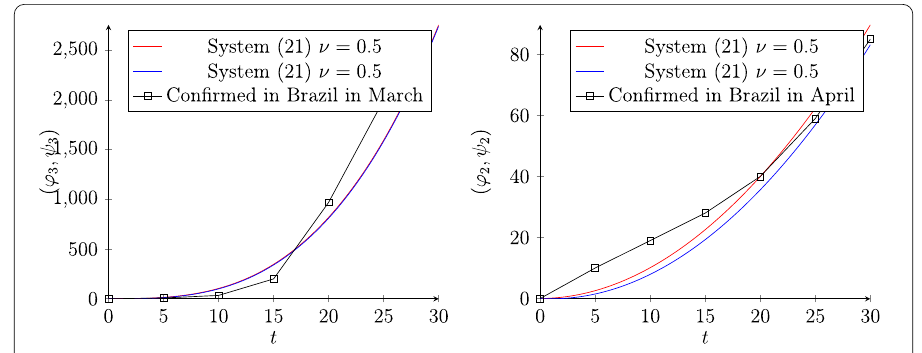
Figure 3 The dynamic evolution of system (21) when ν = 0.5, for Brazil in March and April, respectively. In March the number of infections was per person, therefore, we used ( ϕ 3 , ψ 3 ). In April the data was